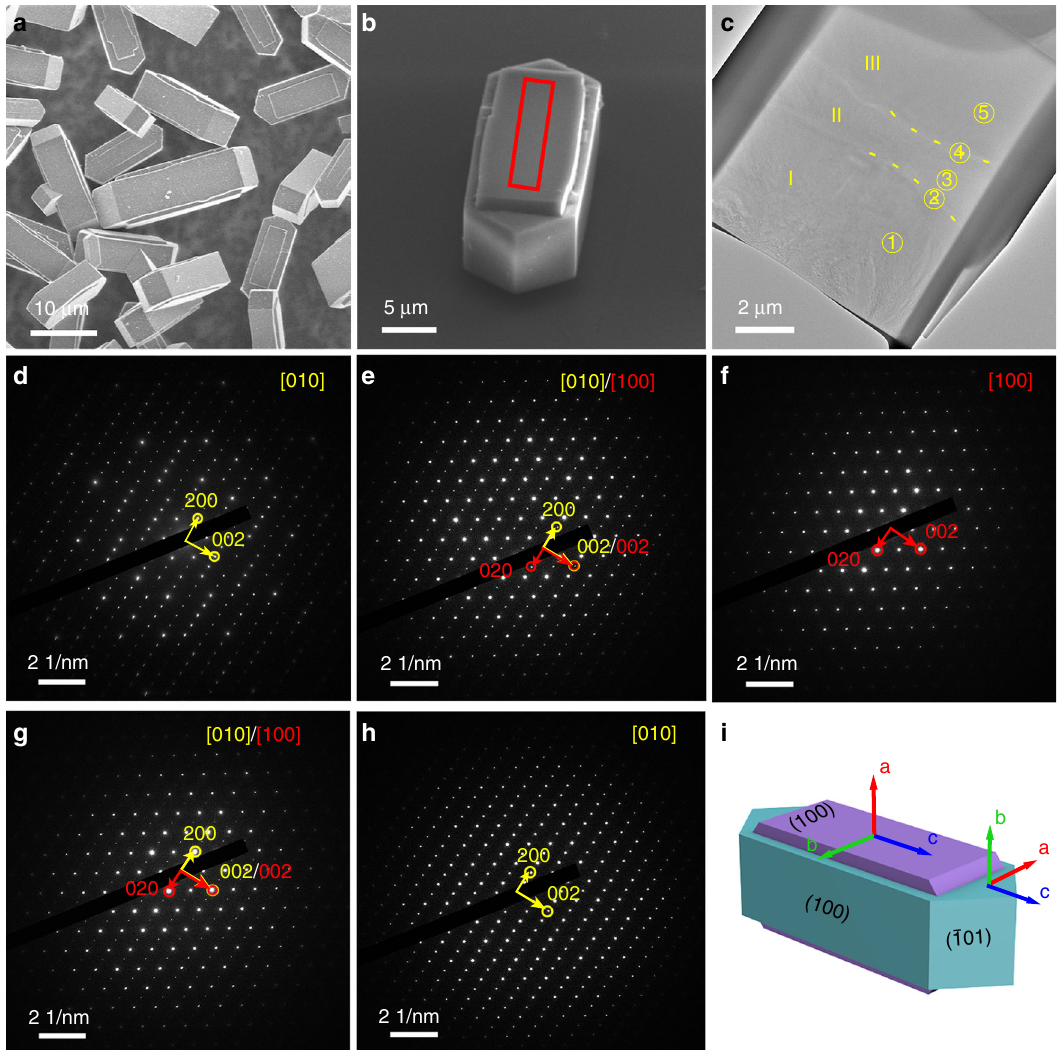
Fig. 3 Structural details of HZSM-5_T crystal. a SEM images of HZSM-5_T crystals showing a highly intergrowth morphology, with the front facet of each main crystal covered by corresponding intergrowth twin crystal. b A thin cross-section cut from the central part of this crystal (marked with a red rectangle) was fabricated by FIB. c TEM side view of the lamella taken from b . The lamella contains three domains that are separated by two boundaries partially highlighted by yellow dashed lines. The areas from area ① to ⑤ were selected for SAED. d – h show SAED patterns correspond to areas in c from ① to ⑤ , respectively. Based on the unit cell parameters and Pnma symmetry, the main indexes are marked in yellow and red for different twin domains. i The deduced twinning model of HZSM-5 crystals, where the two twin components, marked in blue and purple, differ in their crystallographic orientation by 90° rotation over the common c